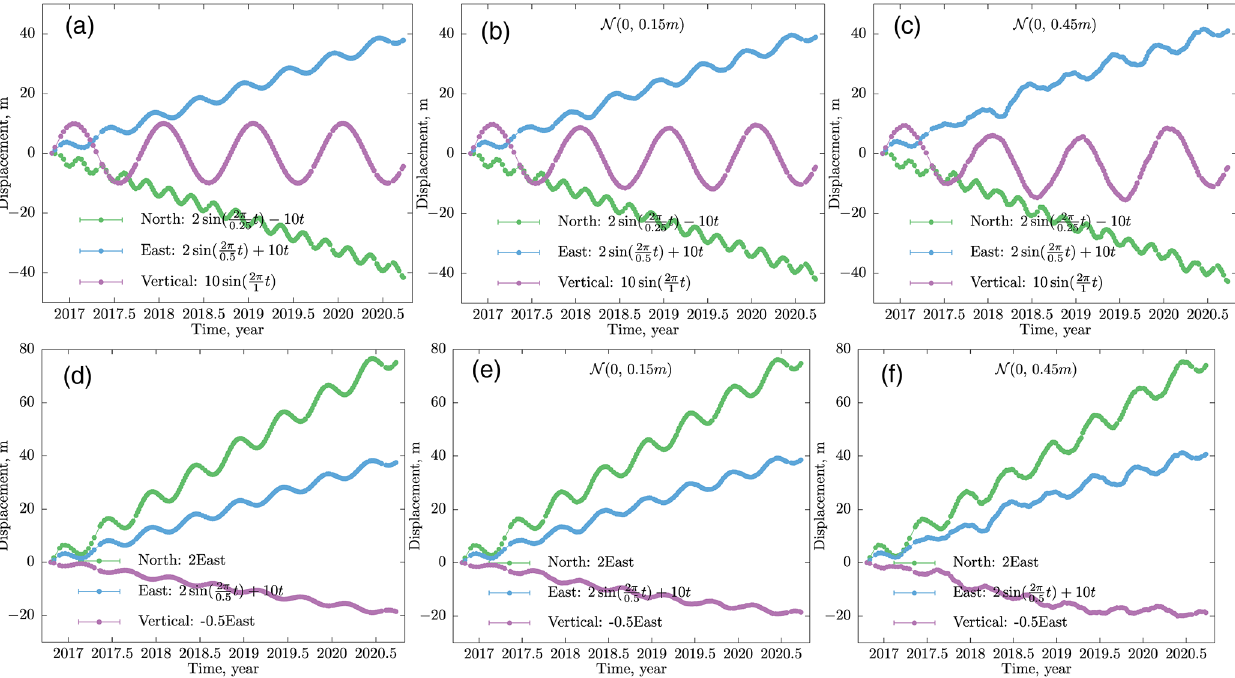
Figure 3. Results of numerical simulations demonstrating the ability of this technique to reconstruct complex uncorrelated and correlated input signals in all three components. Equations of input signals are shown in corresponding subfigure legends; t is time. Harmonic and linear input signals are assumed. Gaussian noise with a mean value of zero and standard deviations in the range 0.15–0.45m (which is approximately 10%–30% of the signal) is added to subfigures in the second and third columns. Table 1. Sentinel-1 SAR data used in this study; θ is incidence and φ is azimuth angle. Span θ ◦ φ ◦ Number of SLC swaths Sentinel-1 track 123